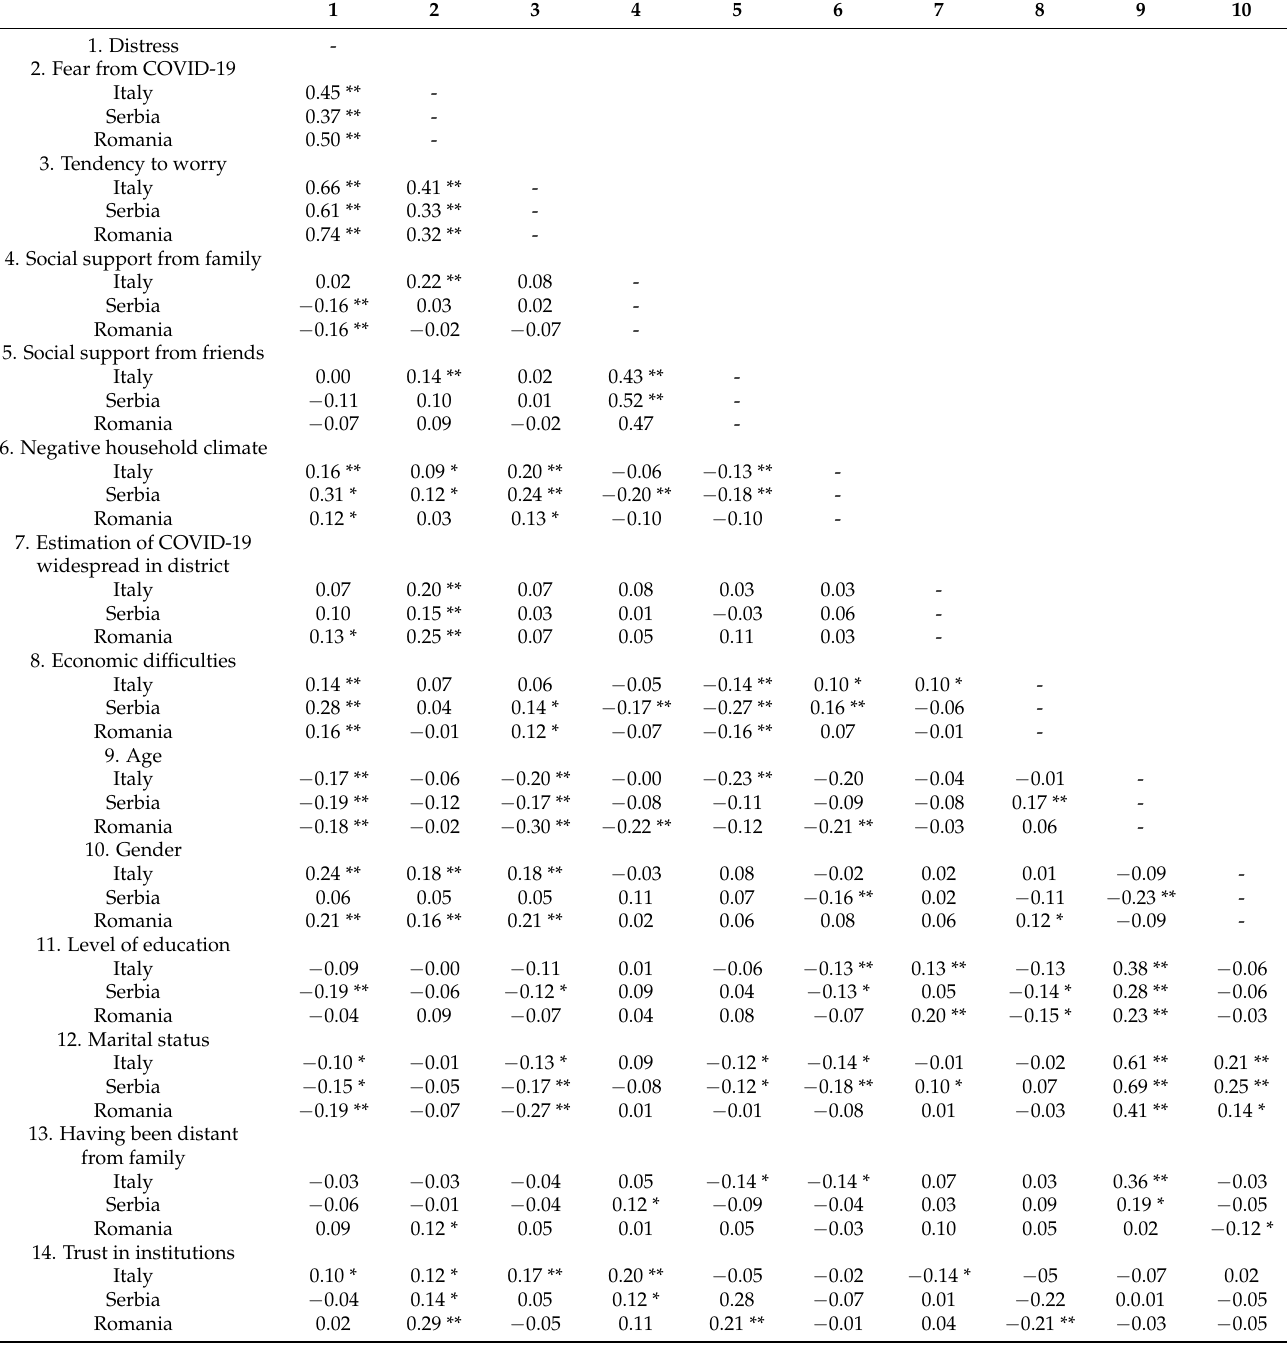
Table 3. Correlations between variables (Italy n = 491; Serbia n = 297; Romania n =